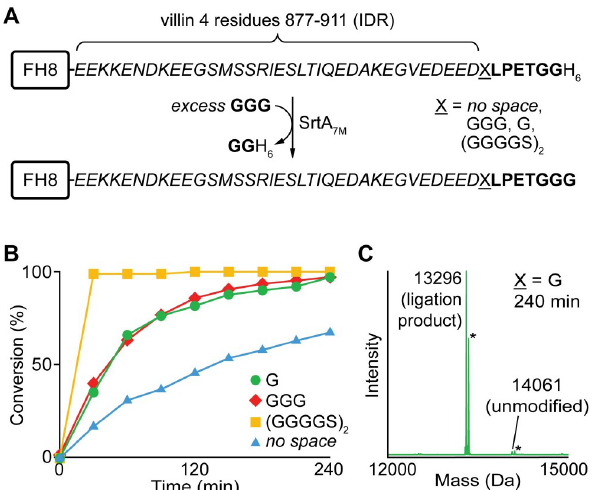
Fig 3. Effect of linker structure on SML using villin 4 IDR substrates. ( A ) Model SML reaction for comparing ligation efficiency with IDR substrates containing different spacers. ( B ) Time course demonstrating improved ligation efficiency when spacers were included between the IDR and LPXTG motif. Reaction progress was estimated using LC-ESI-MS. ( C ) ESI-MS spectrum of SML reaction mixture for the substrate containing a single glycine (G) spacer following a 4 h incubation at room temperature (calculated MWs: unmodified substrate = 14062 Da, ligation product = 13296 Da, � = MeCN adducts from LC-ESI-MS mobile phase).